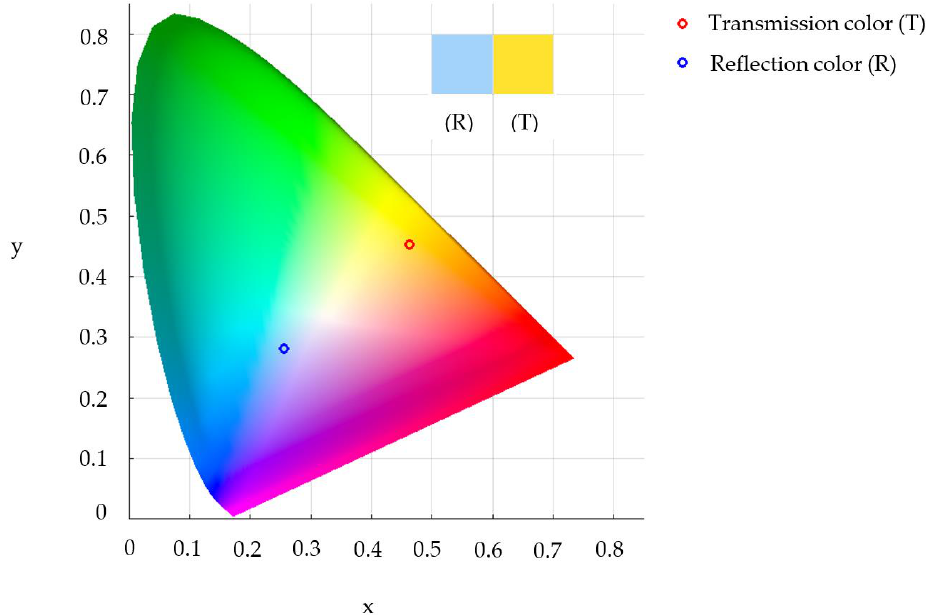
Figure 12. The CIE chromaticity diagram with the proposed color-changing nano-film colors.